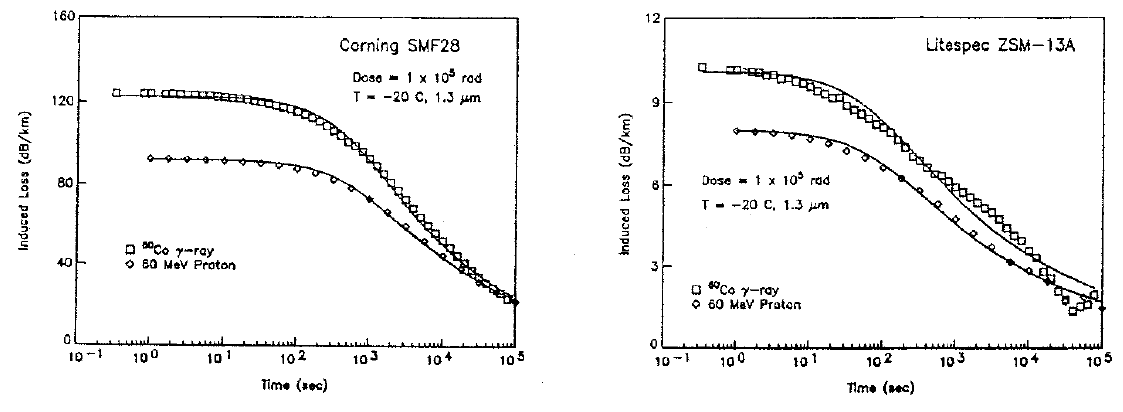
Figure 9. Recovery of gamma induced losses in fibers, reprinted with permission from [19]. Copyright 1996